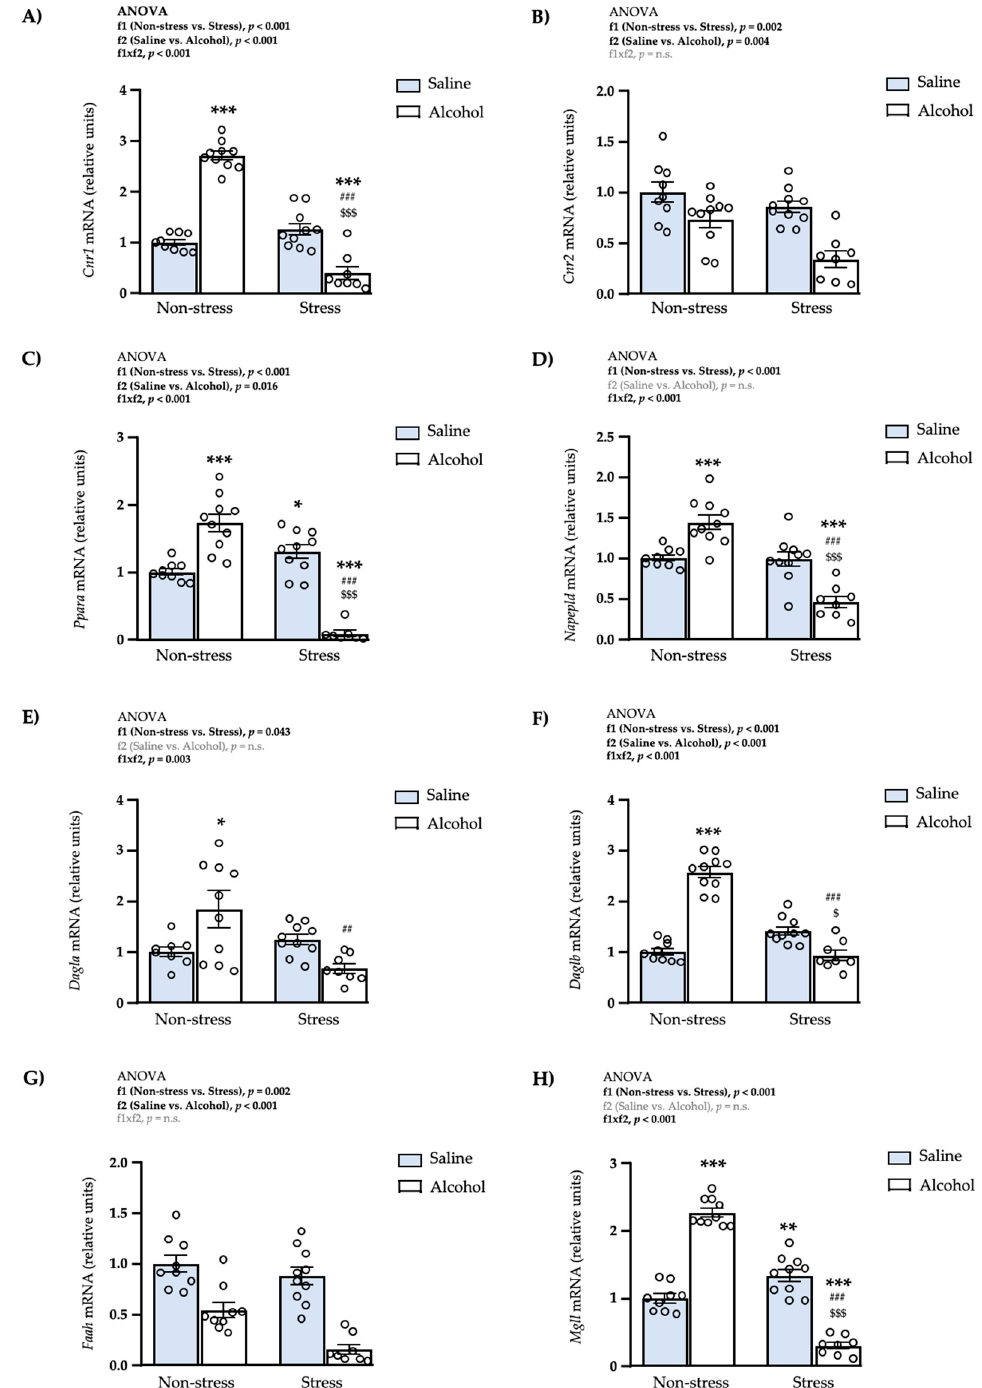
Figure 7. Relative mRNA expression levels of endocannabinoid-signaling genes in the mPFC of adult male rats after repeated restraint stress and/or intermittent alcohol exposure during